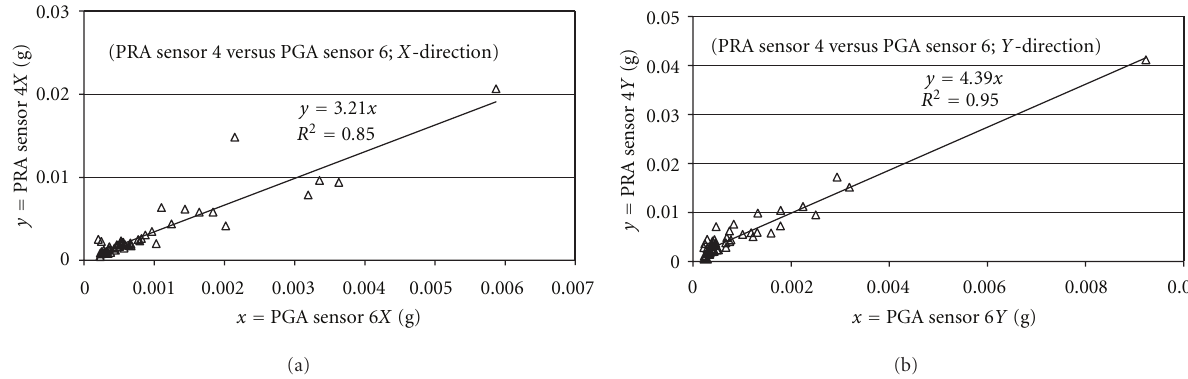
Figure 7: PRA of building A recorded by sensor 4 versus PGA at base recorded by sensor 6: (a) X -direction and (b) Y -direction.